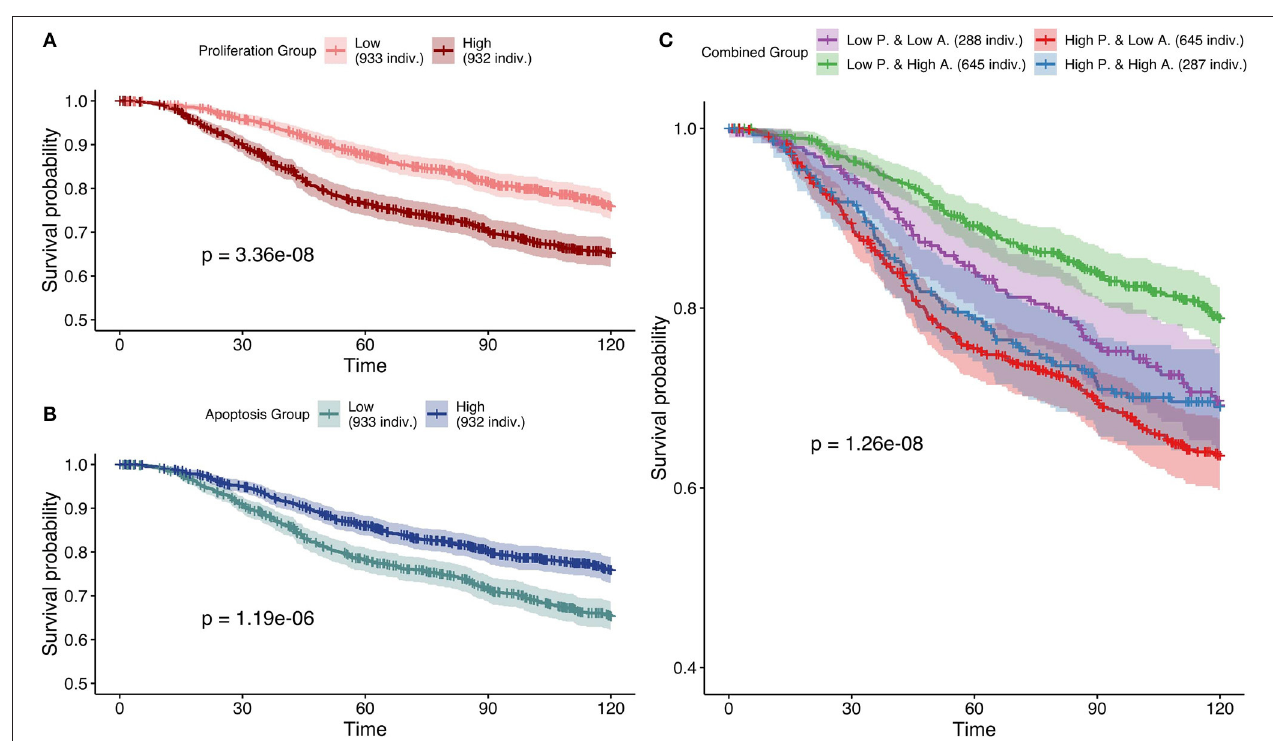
FIGURE 9 | Survival analyses of METABRIC samples from which exome mutations are used as Strict Node Variants and CNA as Soft Node Variants in the model (case 3). All p -values are derived from a log-rank test. (A) Survival curves with high and low Proliferation groups. (B) Survival curves with high and low Apoptosis groups. (C) Survival curves with combined groups.